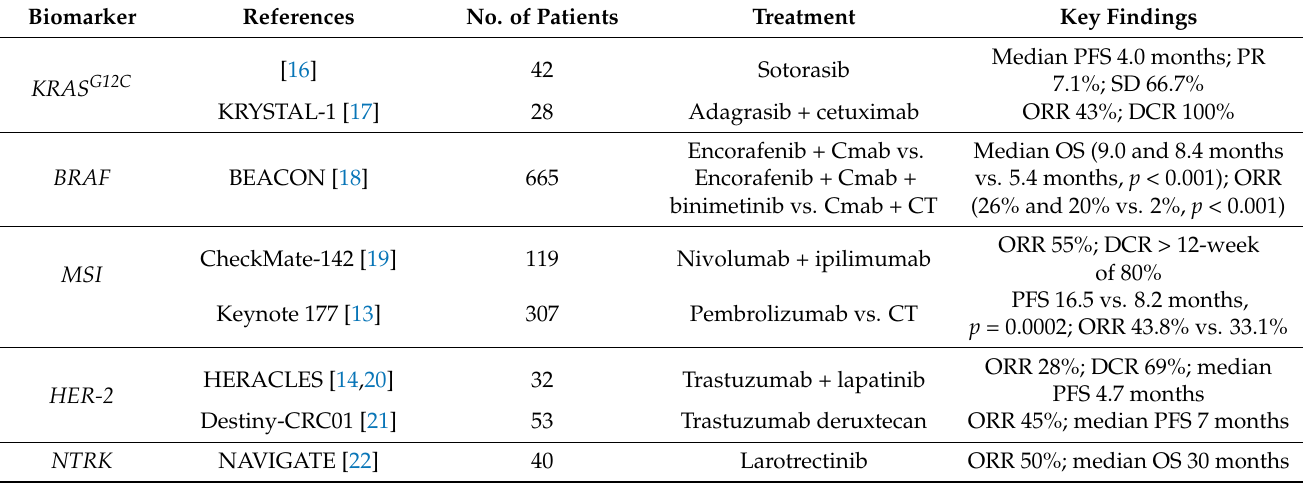
Table 1. Selected trial data for emerging biomarkers in mCRC.